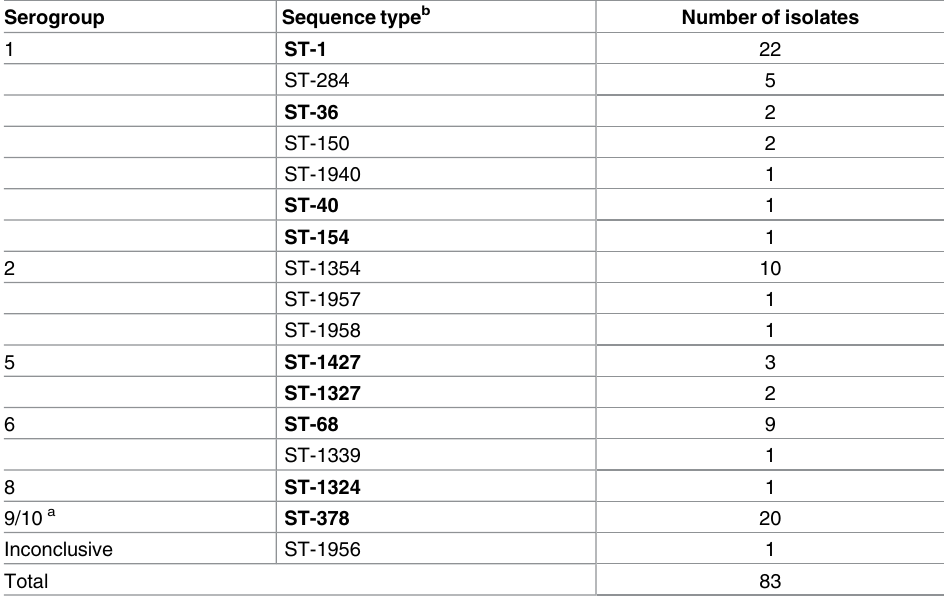
Table 2. Legionella pneumophila environmental isolates typed at LSPQ between 2005 and 2015.